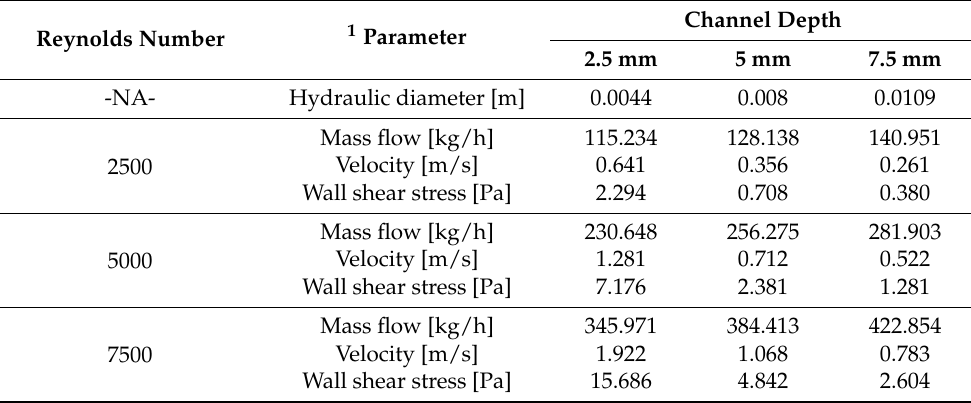
Figure 1. New design for a PPFC. Figure 2. The fully assembled PPFC: ( A ) top view of the flow measurement cell and ( B ) side view of the flow measurement cell.